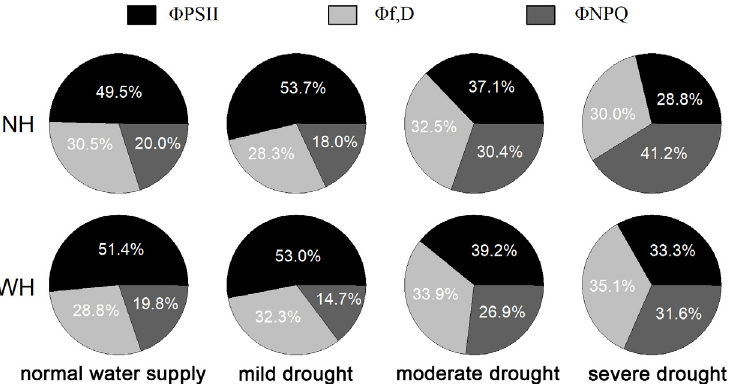
Figure 3. Light energy distribution in leaves of S. album . Effects of water and host on light energy distribution of S. album seedling leaves ( n = 10). NH, grown without host; WH, grown with